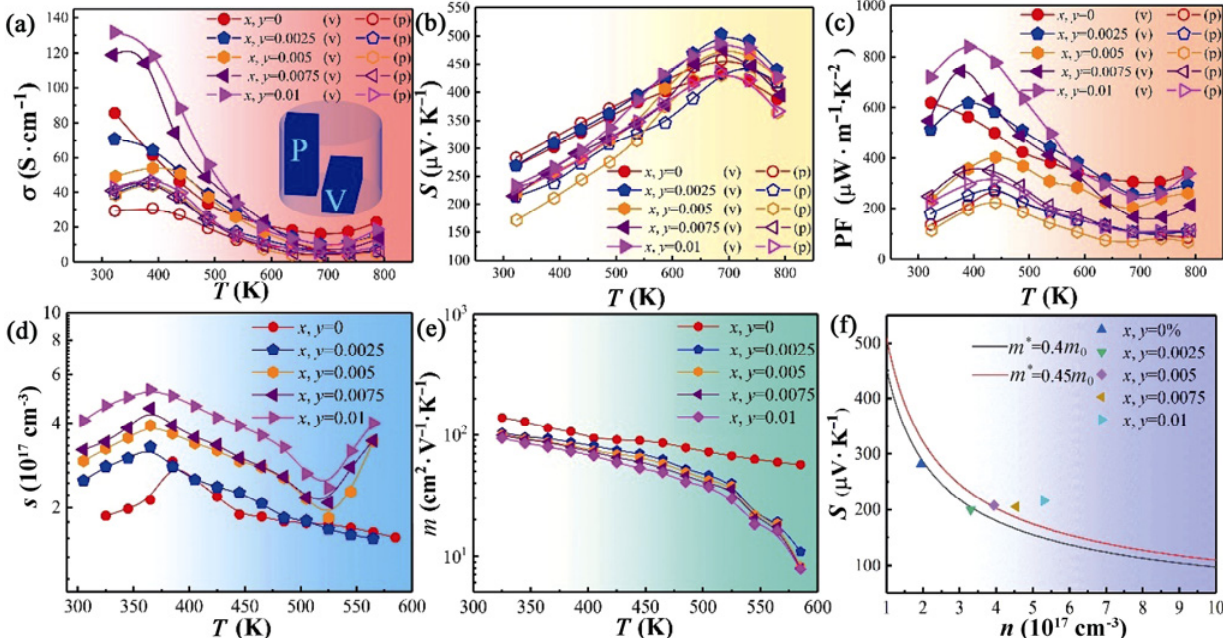
Fig. 8 Temperature dependence of Cu and Ce co-doped SnSe samples: (a) electrical conductivity; the inset shows test properties along different pressure directions (“v” presents perpendicular direction to sintering pressure, and “p” presents parallel direction to sintering pressure); (b) Seebeck coefficient; (c) PF; (d) carrier concentration; (e) mobility; and (f) Seebeck coefficient as a function of carrier concentration (Pisarenko plots) for Sn 1 − x − y Cu x Ce y